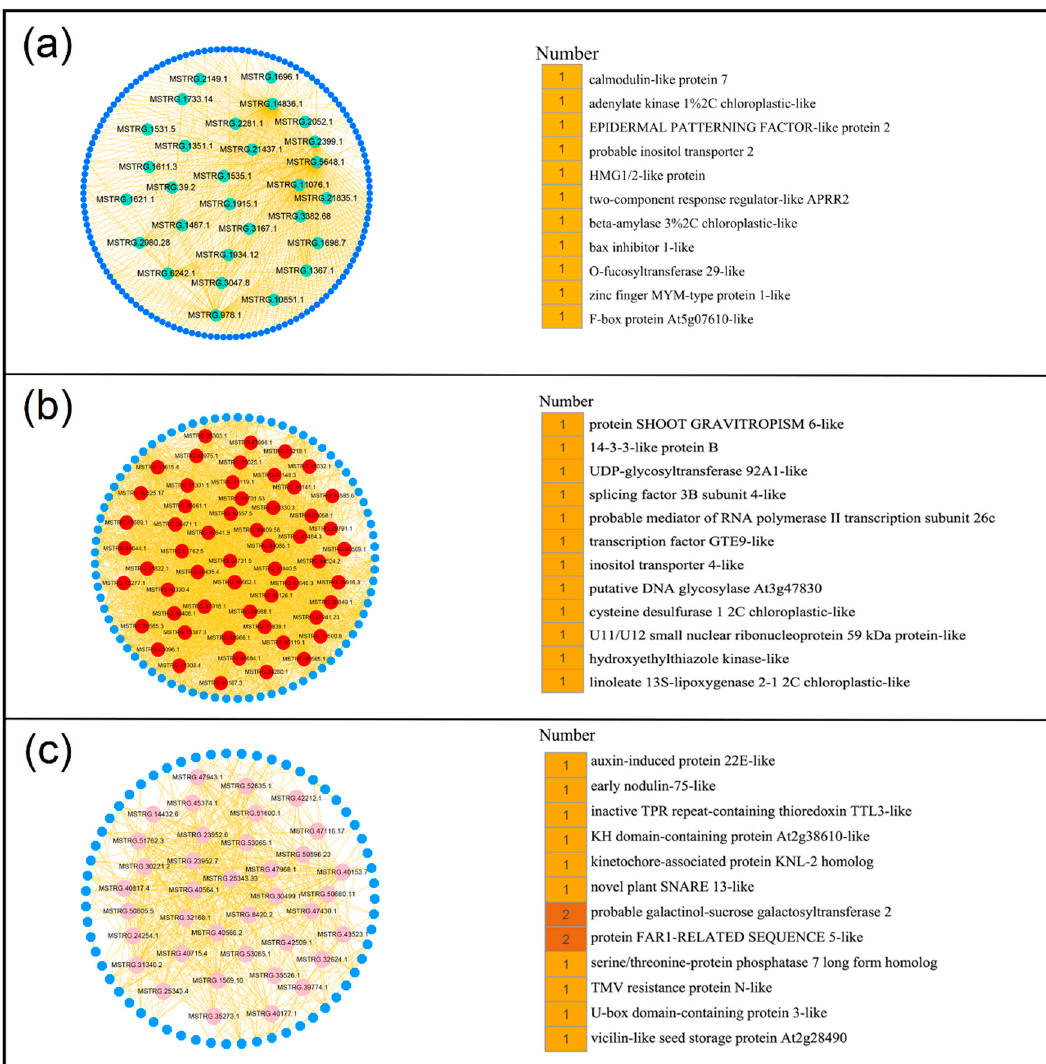
Figure 5. Constructing co-expression network associated with turquoise, pink, and red modules. ( a ) Turquoise module. ( b ) Red module. ( c ) Pink module. ( Left) The network of hub lncRNA is shown in circular. ( Right ) Functional annotation of the target genes of the hub lncRNAs.